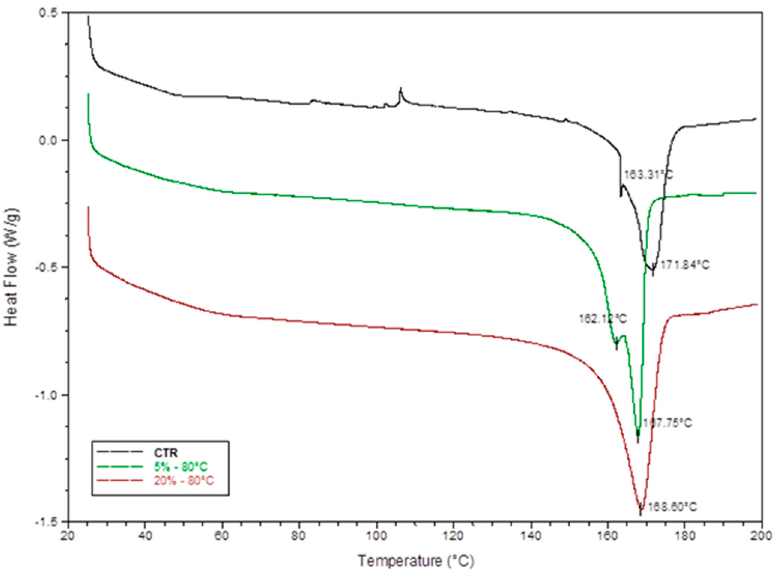
Figure 4. DSC thermograms of samples casted at 80 ◦ C from PVDF solution at 5 and 20% and for Figure 4 . DSC thermograms of samples casted at 80 °C from PVDF solution at 5 and 20% and for pure PVDF pellets used as control. pure PVDF pellets used as control.